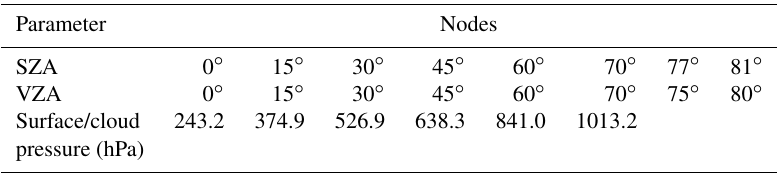
Table 2. Nodes of the solar zenith angle (SZA), viewing zenith angle (VZA), and surface/cloud pressure, as used in the precomputed SO 2 Jacobians lookup